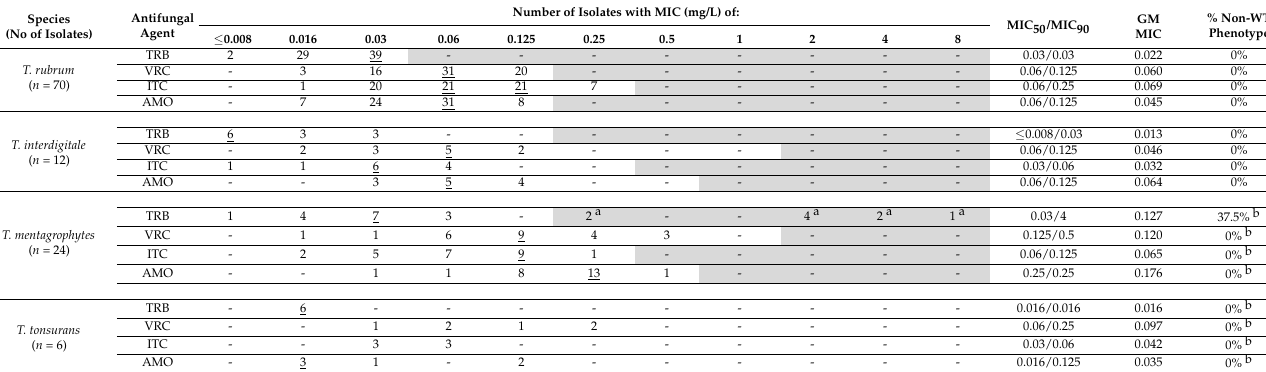
Table 1. In vitro susceptibility profile of 112 Greek Trichophyton spp. clinical isolates determined with the EUCAST E.DEF 11.0